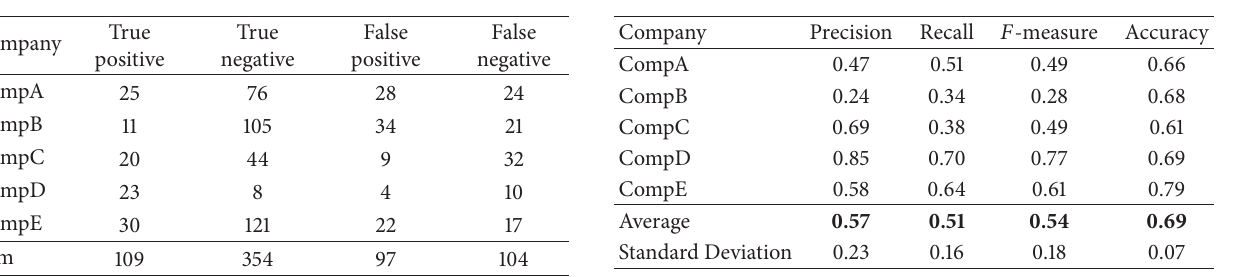
Table 4: Measured data. Table 5: Evaluation